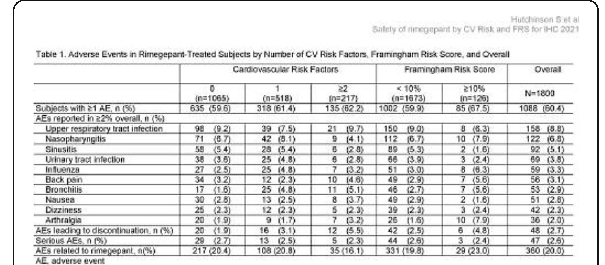
Table 1 (abstract P0266). See text for description